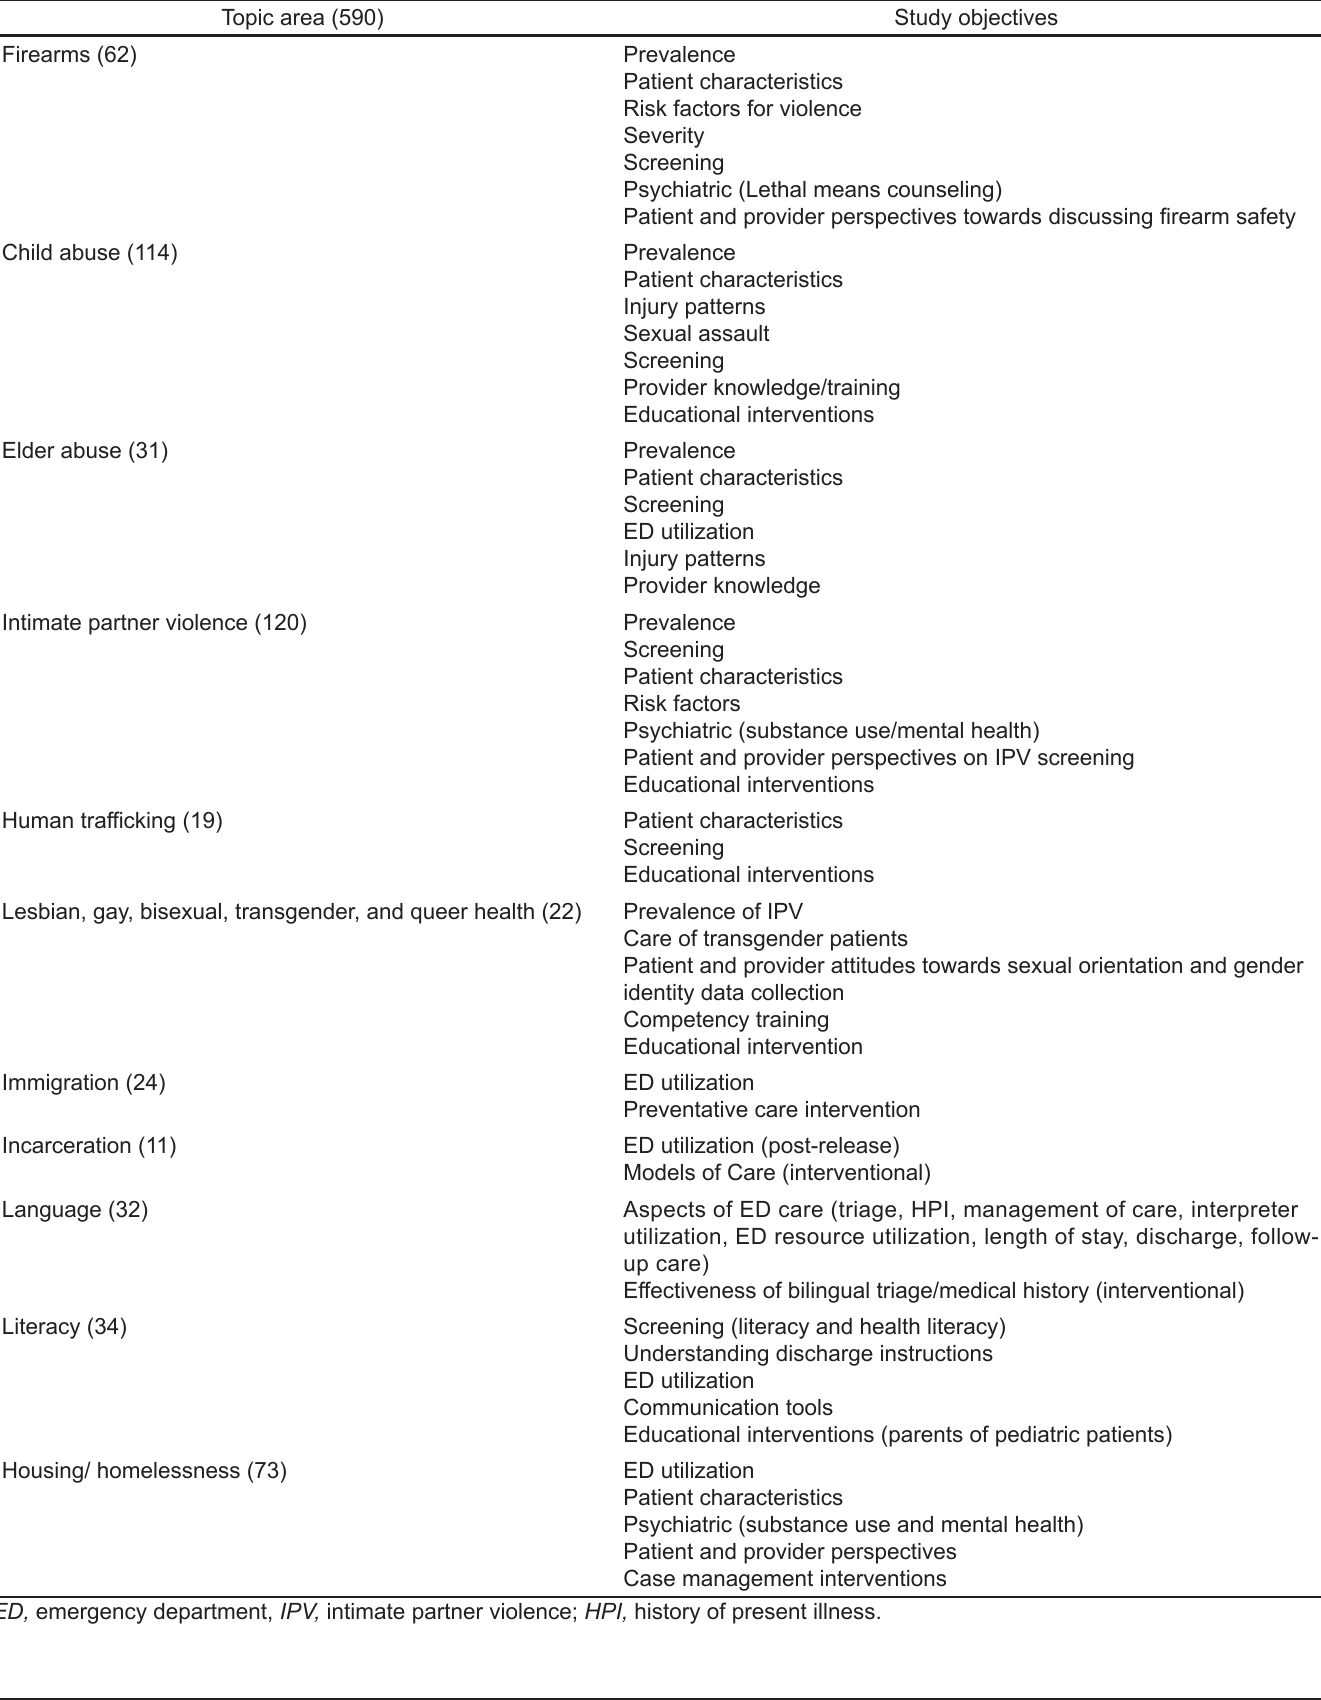
Table. Number of included publications and their most frequent study objectives in the social emergency medicine